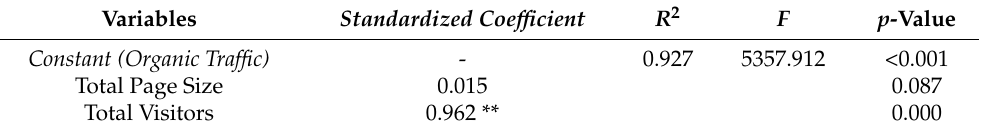
Table 4. First hypothesis’ Regression.